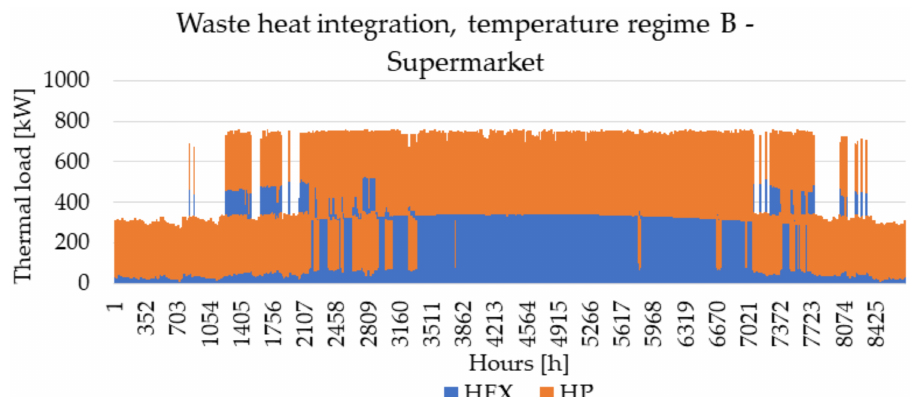
Figure A3. Waste heat utilization per technology, DH temperature regime B—supermarket.